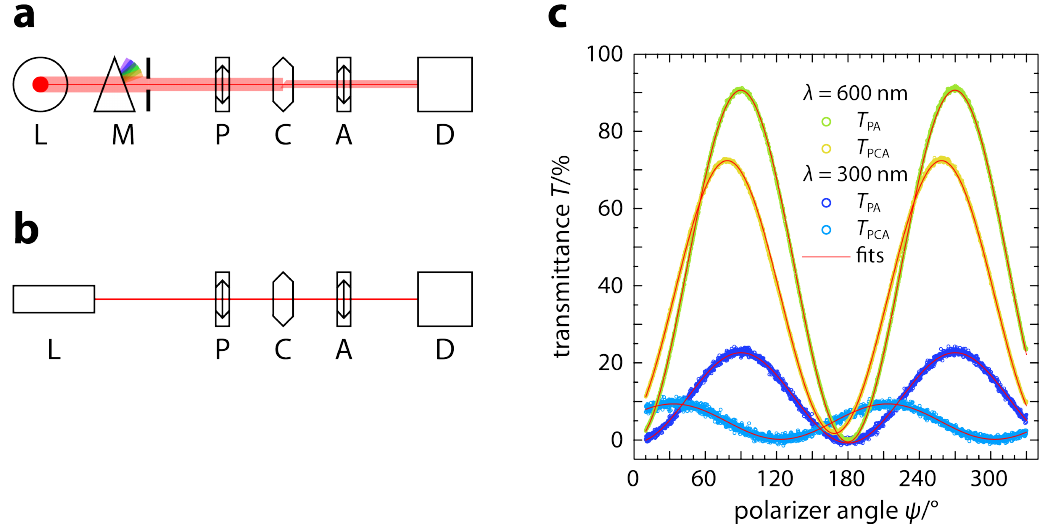
Figure 1. Experimental setup for the measurement of the optical rotatory power. ( a , b ) Arrangement of optical components in the spectrophotometer and for a setup using a laser as the light source. L: light source (deuterium or tungsten lamp in ( a ) and He-Ne laser in ( b )), M: monochromator, P: rotatable polarizer, C: optically active crystal, A: rotatable analyzer, D: detector. ( c ) Transmittance through polarizer and analyzer (PA) and through polarizer, YAB crystal, and analyzer (PCA) recorded with the spectrophotometer as a function of the polarizer